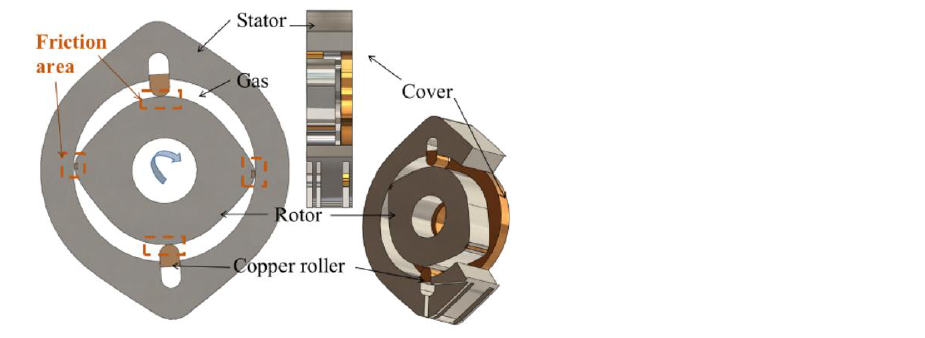
Figure 1. Schematic diagram of the designed pneumatic downhole motor with a steel–copper seal.